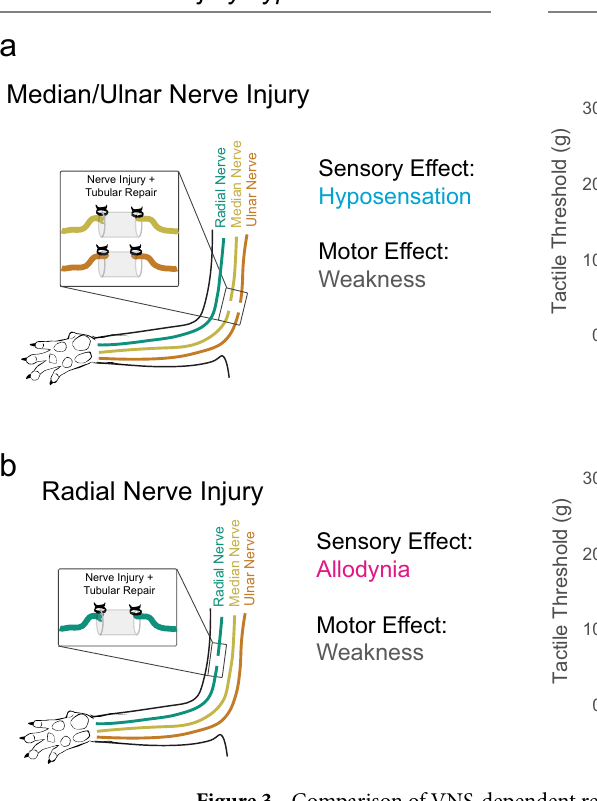
Figure 3. Comparison of VNS-dependent recovery in hypersensitive and hyposensitive models of nerve injury. ( a ) In previous studies, damage to the median and ulnar nerves causes somatosensory hyposensitivity and weakness in the forelimb. Pairing VNS with tactile rehabilitation significantly improves elevated sensory thresholds, restoring them to normal levels. Data from 6 . Additionally, VNS paired with motor rehabilitation significantly improves forelimb weakness compared to equivalent training without VNS. Data from 5 . ( b ) In the present study, injury to the radial nerve in the forelimb causes allodynia and weakness. Pairing VNS with tactile rehabilitation fails to restores somatosensory function. Moreover, VNS paired with motor rehabilitation fails to improve recovery forelimb strength compared to equivalent training without stimulation. The absence of VNS- dependent benefits in either somatosensory and motor recovery after radial nerve injury likely arise due to the chronic pain induced by the